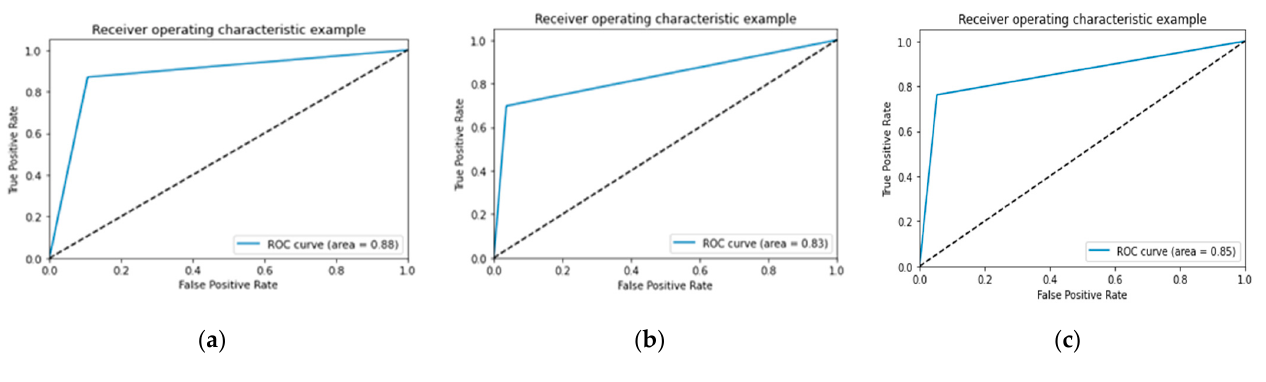
Figure 11. Performance of ROC curve for VGG-16: ( a ) infarction; ( b ) ischemia; ( c ) normal.